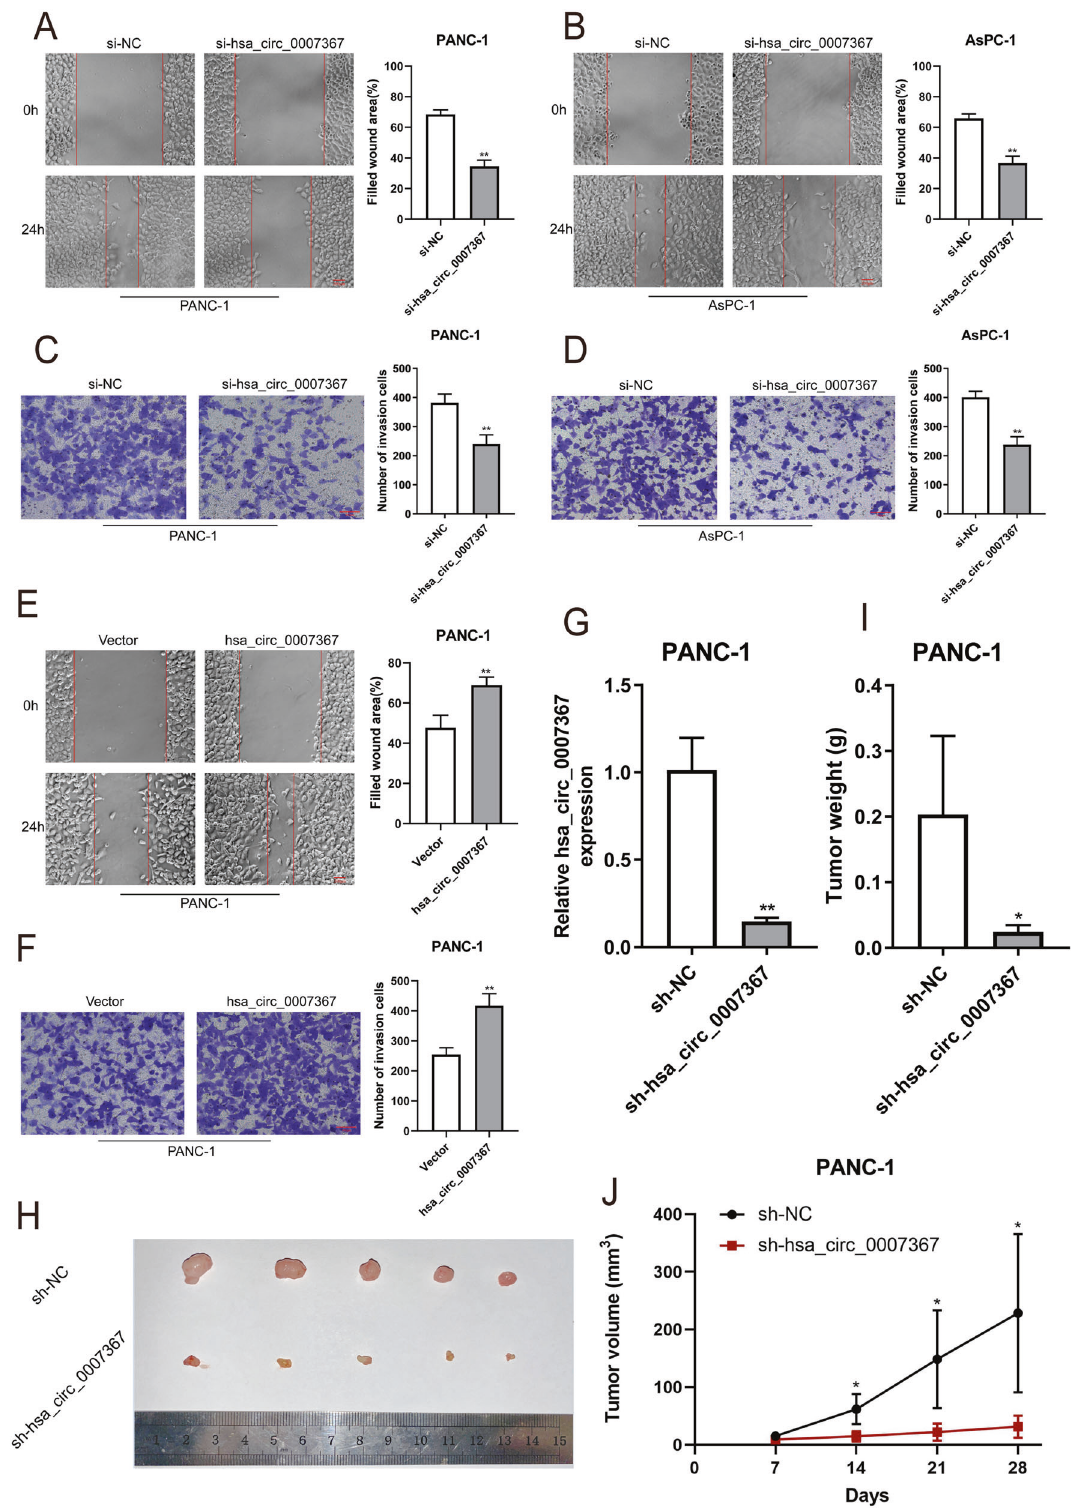
Fig. 3 Hsa_circ_0007367 promotes the migration and invasion of PDAC cells in vitro and knockdown of hsa_circ_0007367 inhibits PDAC cell growth in vivo. A , B The migration was measured by the wound-healing assays in PANC-1 and AsPC-1 cells after knockdown of hsa_circ_0007367. C , D Transwell invasion assays were performed to verify the invasion capability after knocking down hsa_circ_0007367 in PANC-1 and AsPC-1 cells. E , F PANC-1 cells transfected with the hsa_circ_0007367 plasmid to detect the migration and invasion capability by wound-healing and transwell invasion assays. G Hsa_circ_0007367 knockdown ef fi ciency was detected by qRT-PCR in PANC-1 after transfected with sh-hsa_circ_0007367 and sh-NC plasmid. H Representative image of subcutaneous xenograft tumors at day 28 after knockdown of hsa_circ_0007367 compared with sh-NC in PANC-1 cells. I , J Tumor volume and weight of xenograft after knockdown of hsa_circ_0007367 compared with sh-NC. All data are shown as the mean ± SD of at least three independent experiments. * p < 0.05, ** p < 0.01. Cell Death and Disease (2022)